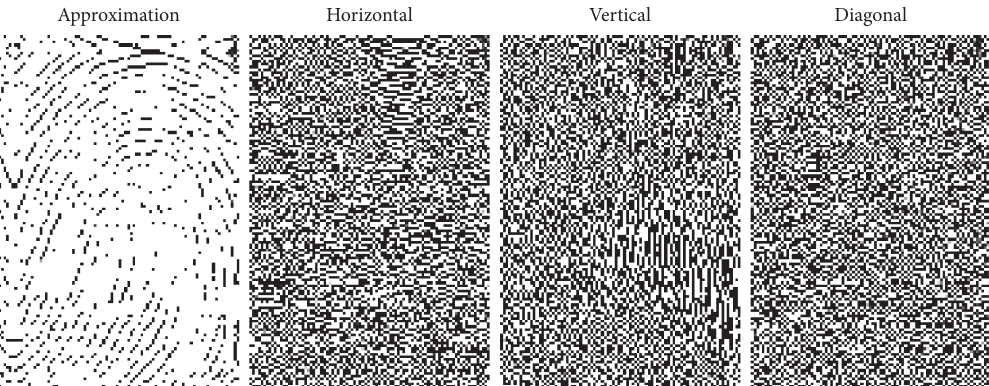
Figure 13: Details of DWT fingerprint image decomposition.